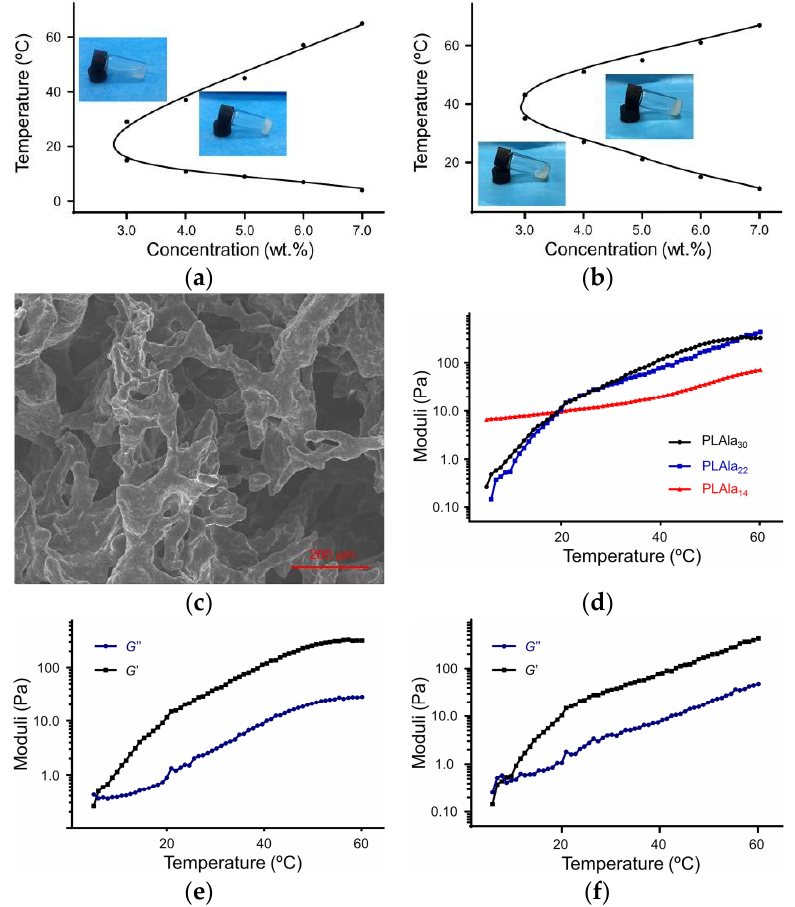
Figure 2. Gelatinization characteristics of mPEG 45 −PLAla. ( a ) Solution–gel phase diagrams of the mPEG 45 −PLAla 30 and ( b ) mPEG 45 −PLAla 22 copolymer solutions; ( c ) Scanning electron microscope (SEM) image of mPEG 45 −PLAla 30 hydrogels formed at 40 °C; ( d ) G ’ of the mPEG 45 −PLAla 30 (PLAla 30 ), mPEG 45 −PLAla 22 (PLAla 22 ), and mPEG 45 −PLAla 14 (PLAla 14 ) at the concentration of 5.0 wt. % in phosphate-buffered saline (PBS) solution; ( e ) Changes of G ’ and G ” of mPEG 45 −PLAla 30 and ( f ) mPEG 45 −PLAla 22 in PBS solutions (5 wt. %).